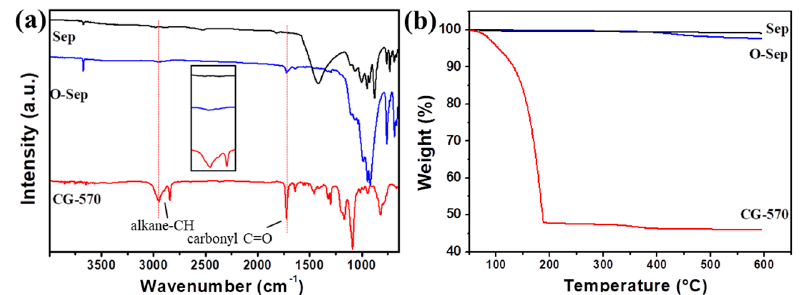
Figure 1. ( a ) FTIR and ( b ) TG curves of sepiolite (Sep), CG570, and organo-sepiolite (O-Sep), the dark lines, red lines, and blue lines in the figure represent Sep, CG–570, and O-Sep, respectively.